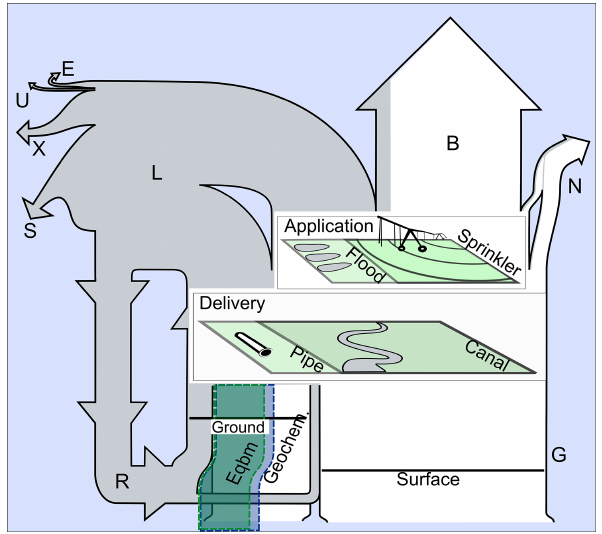
Figure 2. Diagram of fates of water abstracted for irrigation across the USRB. Flow-line widths are scaled proportionally to fluxes across the simulation domain between 2008 and 2017 at the baseline parameterization. White depicts abstractions from pristine sources, whereas water lost nonconsumptively from irrigation delivery or ap- plication during the model epoch is gray. Equilibrium (Eqbm) and geochemical (Geochem.) fractions of groundwater abstractions re- lax assumptions about aquifer water composition and are discussed in Sect. 4.2. Labels of irrigation fluxes are as follows: G – gross irrigation abstractions, B – beneficial consumption by crops, N – nonbeneficial consumption, and L – nonconsumptive losses or in- cidental returns. The remaining fluxes refer to the fate of incidental returns as follows: R – reuse in gross irrigation, E – evaporation, U – human use, X – export, and S – storage in aquifer, soils, and